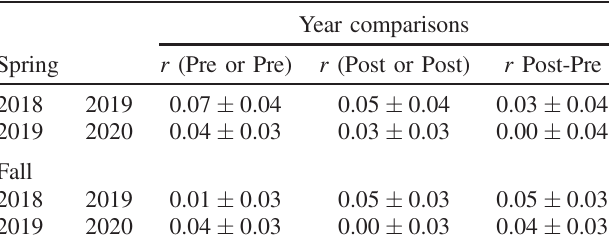
TABLE III. Effect sizes calculated from the results of Mann- Whitney U tests comparing the distributions of student scores (cf. Fig. 1) between pretests and post-tests for different years. Uncertainties correspond to an estimate of the 95% confidence